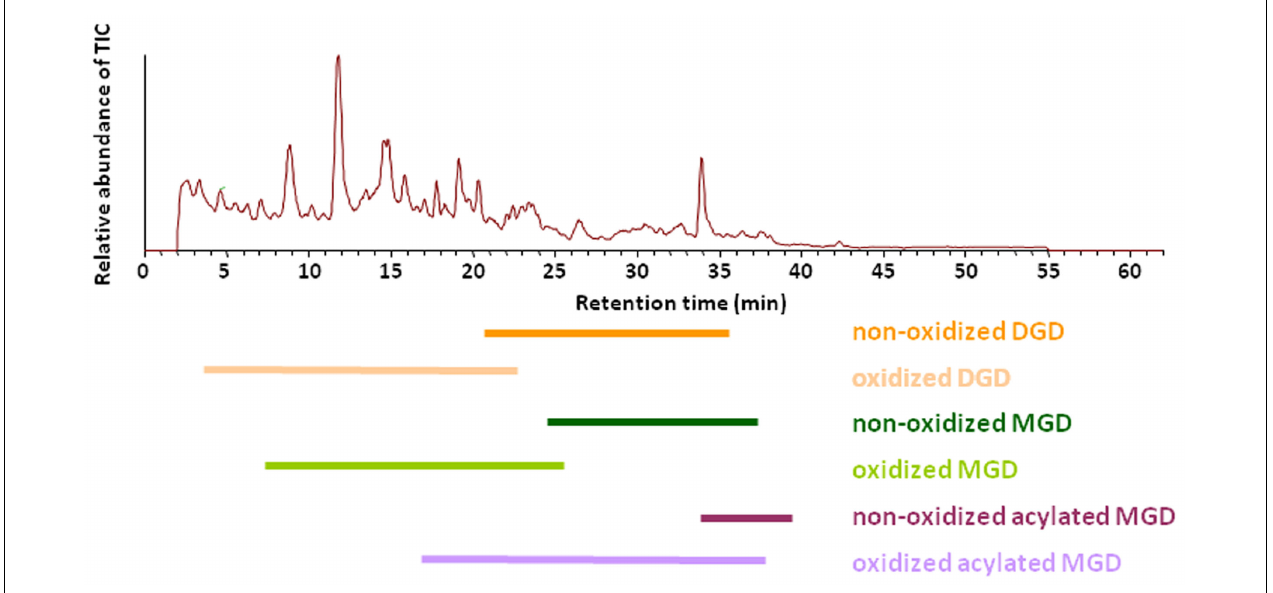
to Bligh and Dyer (1959) from leaves of A. thaliana 30min after wounding. Galactolipid species were detected in positive ESI mode using a mass range of 450–1,500amu.